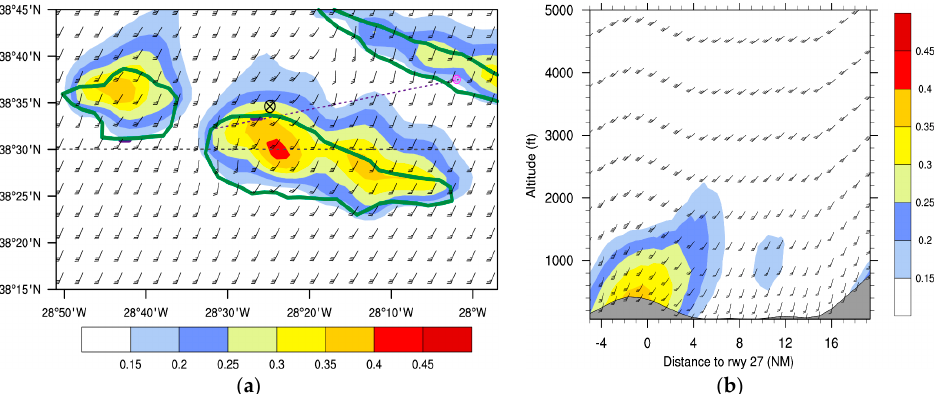
Figure 15. AROME turbulence indicators (bottom x-axis) vs. the wind shear intensity factor “I” (top x-axis), along the flight path during Flight 1. Ellrod TI1, TI2 and Brown indicators are shown in ( a ) and ( c ), respectively. Solid red lines in ( b ) and ( d ) indicate CAT1 and EDR values, respectively.